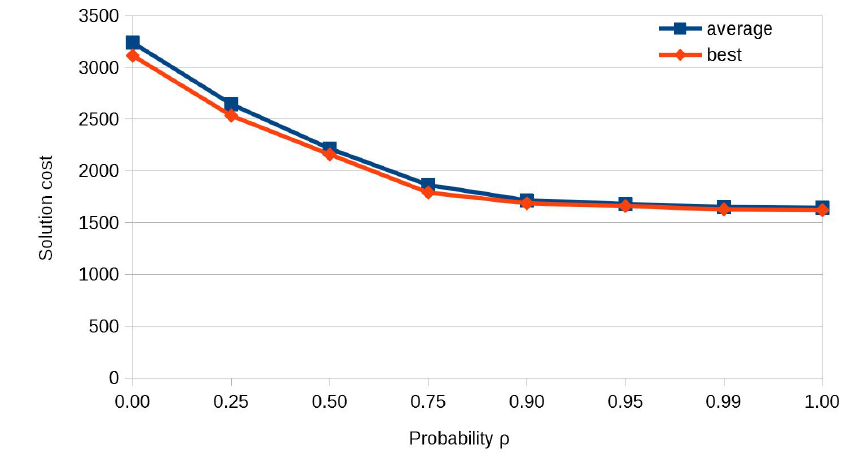
Figure 2. Solution cost for a calibration instance with 100 customers for different values of ρ